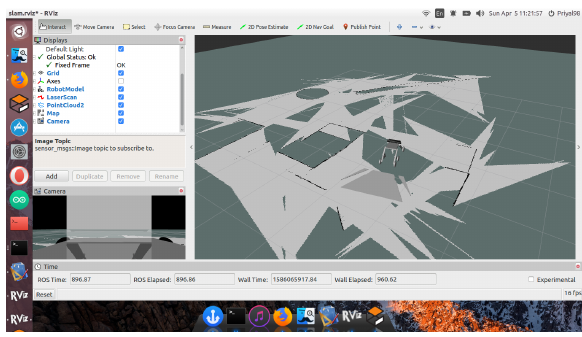
Figure 10. Map generation using gmapping package